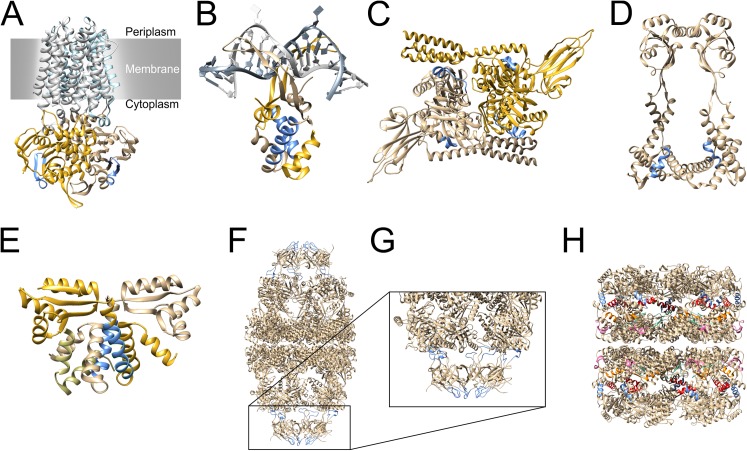
3-dimensional structure models of the closest structural homologues.A) Heterotetramer of a structural homologue of NGO0170 embedded in the cytoplasmic membrane (PDB ID: 2NQ2). B) Homodimer of structural homologue of NGO0777 bound to a DNA double strand (PDB ID: 1P51). C) Homodimer of a structural homologue of NGO1429 (PDB ID: 4JNE). D) Homodimer of a structural homologue of NGO1656 (PDB ID: 3RFW). E) Heterotrimer of a structural homologue of NGO1852 (PDB ID: 1DD3). F) Hetero-28-mer of a structural homologue of NGO2094 (PDB ID: 1PCQ). G) Zoomed in part of the Hetero-28-mer of F. H) Homo-21-mer of a structural homologue of NGO2095 (PDB ID: 1KP8). Identified epitopes are highlighted in blue. Identified epitopes of NGO2095 are marked in red, blue, orange, green and pink.